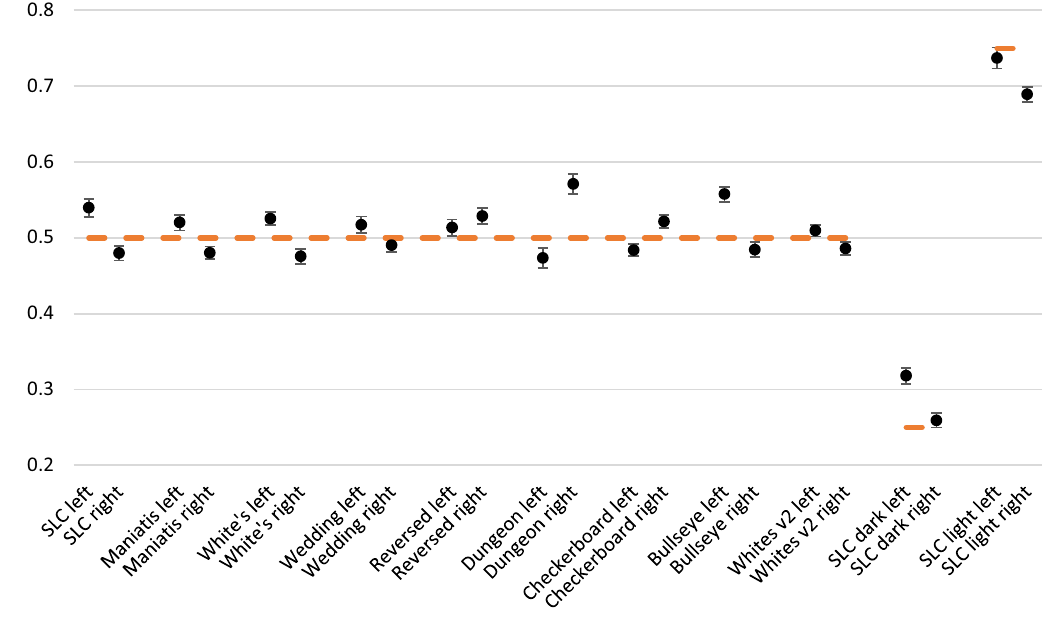
Figure 4. Empirical results from human participants for 11 illusory displays, error bars are 99% confidence